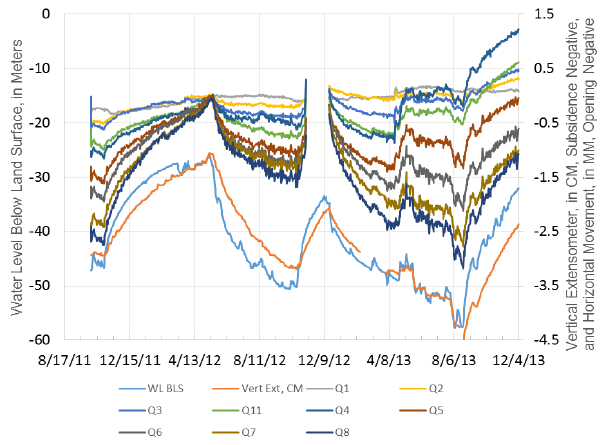
Figure 2. Quartz-tube horizontal movement compared with water- level fluctuation in an observation well and deep-extensometer com- paction 0.8km to the